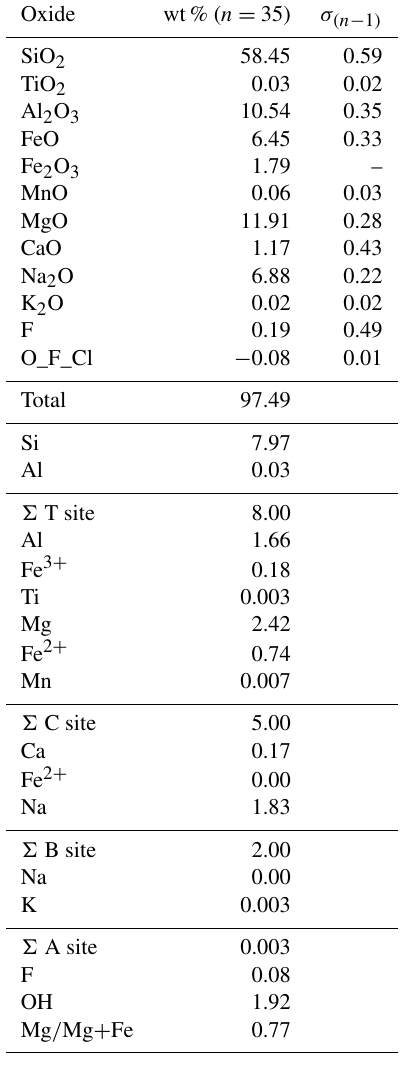
Table 2. Average EMPA data for the studied glaucophane. Chemi- cal formula (in a.p.f.u.) calculated on the basis of 23 oxygen